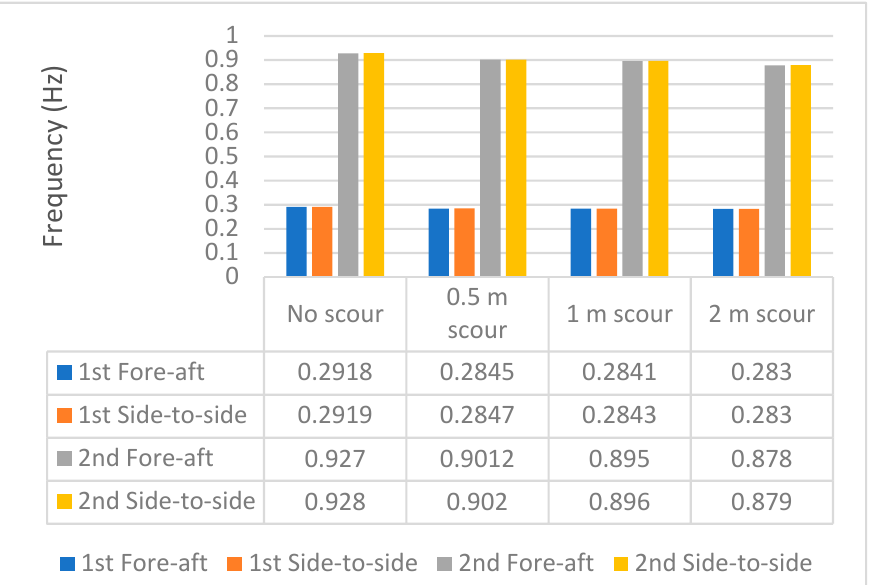
Figure 18. Effect of scour size on the dynamic response.